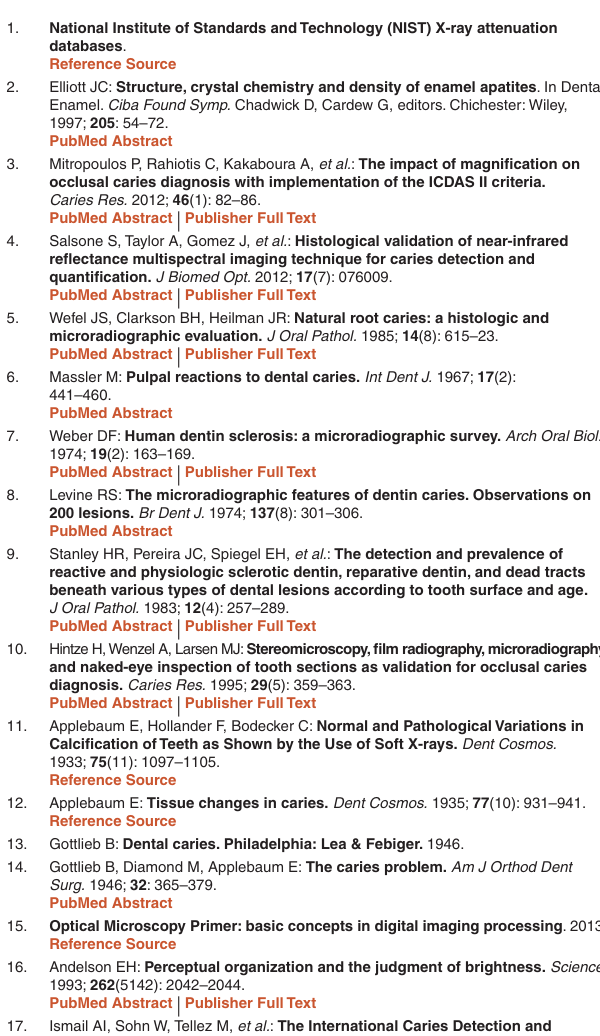
Figshare: Dentin reactions detected from SM and PLMQ, doi:10.6084/m9.figshare.895737